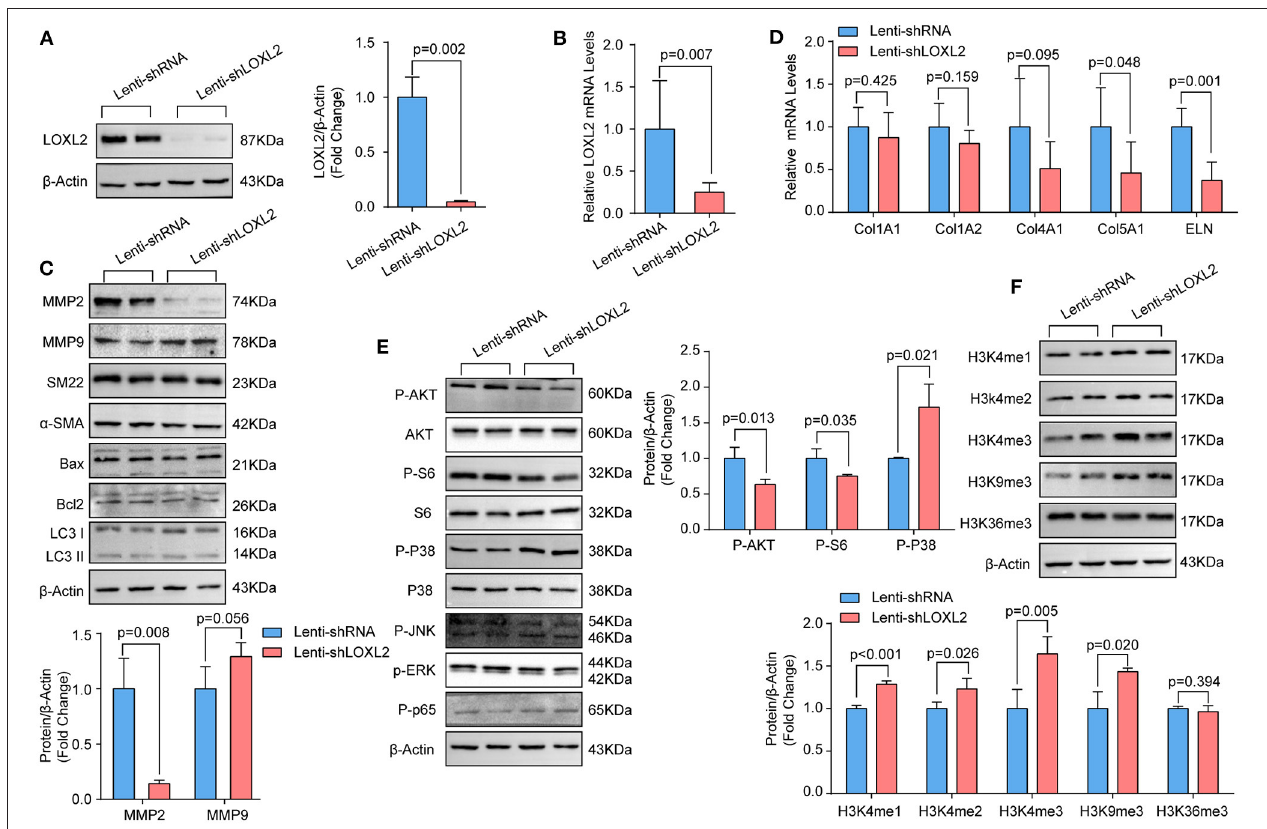
FIGURE 3 | Knockdown of LOXL2 inhibited MMP2 expression and AKT signaling, but facilitated the methylation of H3K4 and H3K9 in primary cultured HASMCs. (A) The protein levels of LOXL2 were evaluated by western blotting ( n = 4). (B) The mRNA levels of LOXL2 in HASMCs infected with lenti-shRNA, lenti-shLOXL2 were detected by RT-PCR ( n = 5). (C) The protein levels of MMP2, MMP9, SM22, Bax, Bcl2, and LC3I/II in HASMCs infected with lenti-shRNA or lenti-shLOXL2 ( n = 4). (D) The mRNA levels of Col1A1, Col1A2, Col4A1, Col5A1, and ELN in HASMCs were detected by RT-PCR ( n = 5). (E) The p-AKT, S6, GSK3 β , p38, ERK1/2, JNK1/2, and p65 in HASMCs was evaluated by western blotting ( n = 4). (F) Western blotting was used to detect the protein levels of H3K4me1, H3K4me2, H3K4me3, H3K9me3, and H3K36me3 in HASMCs infected with lenti-shRNA or lenti-shLOXL2 ( n = 4). β -Actin served as the loading